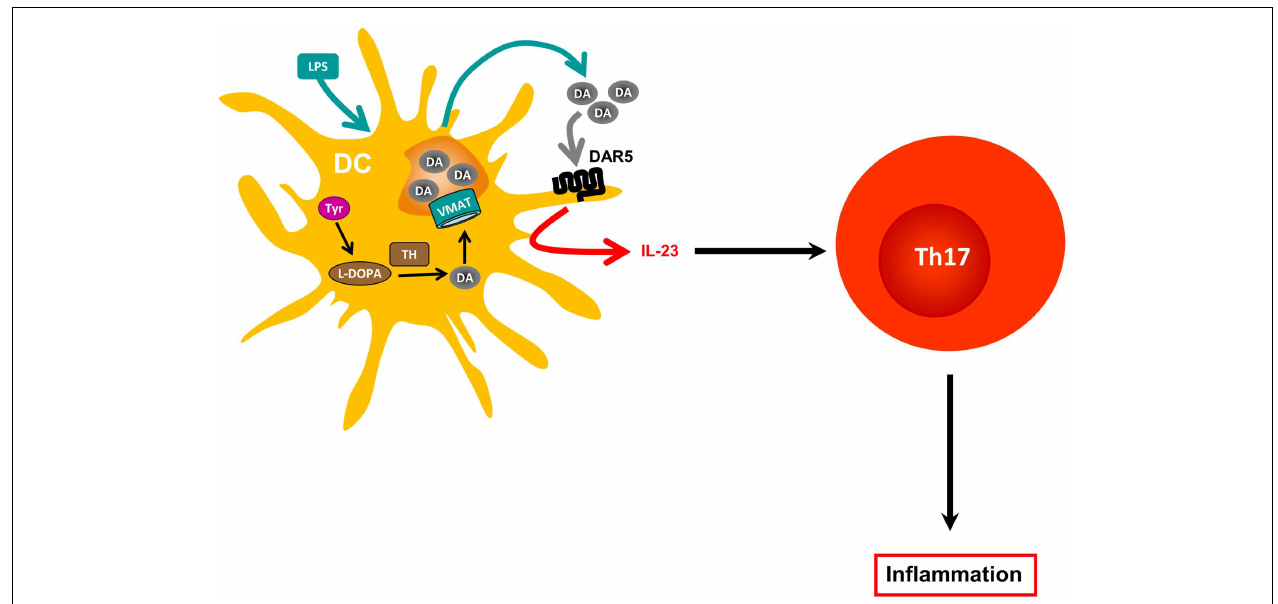
store DA in vesicular compartments. In response to antigen presentation or to LPS stimulation, DCs release DA from intracellular stores, which can modulate both DC physiology in an autocrine manner and CD4 + T cell responses in a paracrine fashion (not depicted). At certain concentrations, DC-derived DA interacts with DAR5 expressed by DCs, which promotes IL-23 production in response to LPS, and, thereby, enhancesTh17